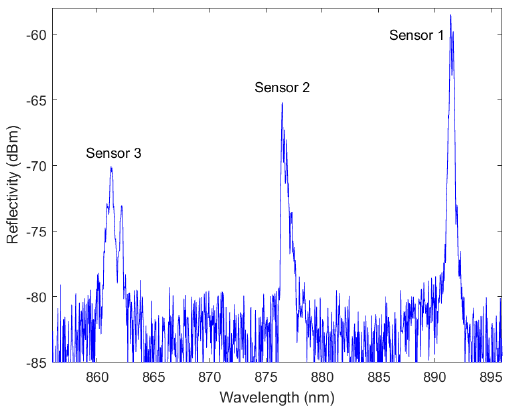
Figure 8. Reflection spectrum of the sensor foil showing the Bragg wavelength of the three sensors multiplexed in the same waveguide.